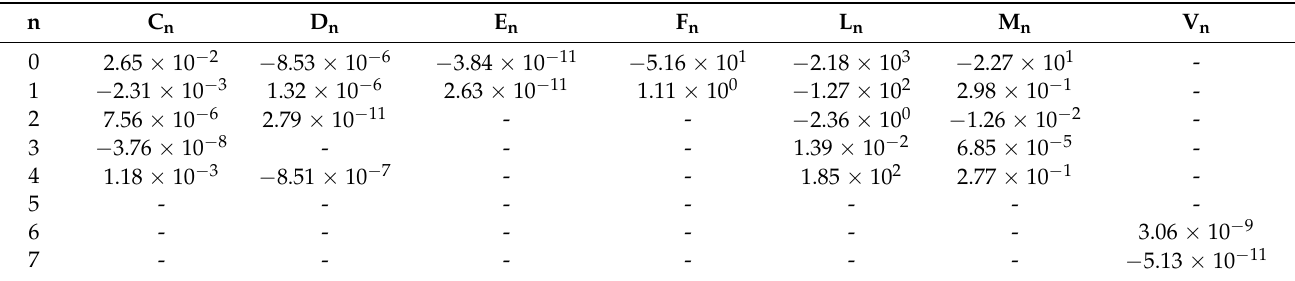
Table A2. Coefficients of the H 2 O-LiBr specific heat